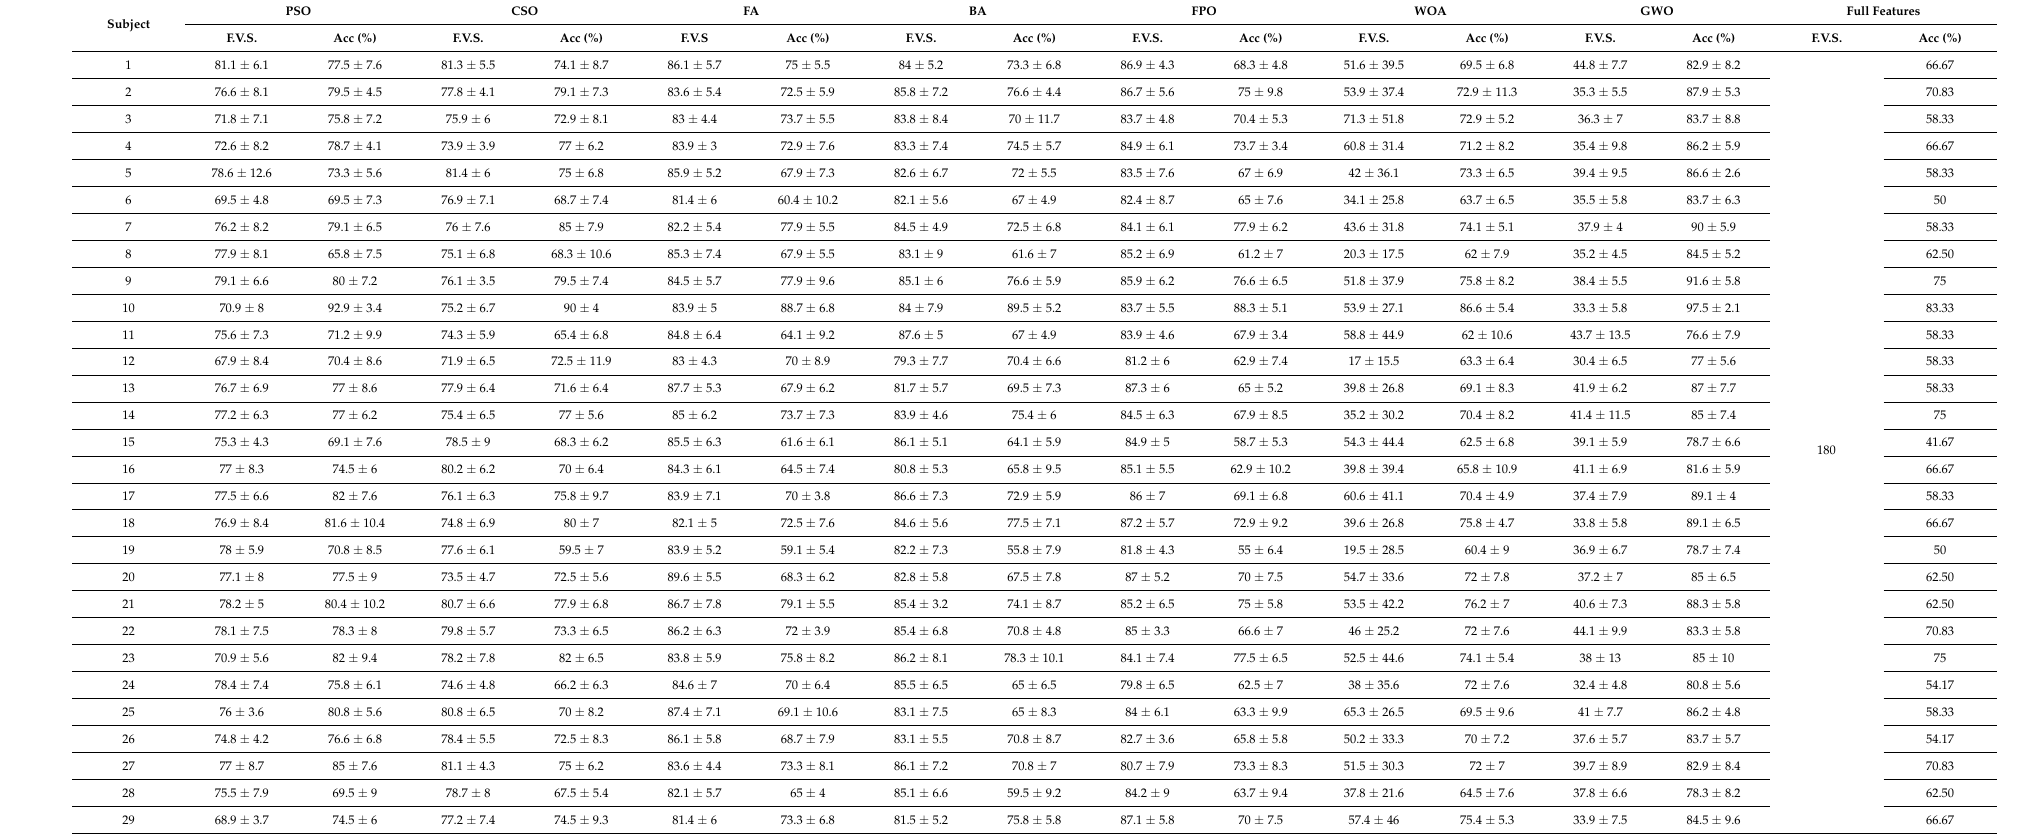
Table 4. Classification performance of each subject for the LHMI, RHMI, MA, and baseline tasks in terms of the accuracy (Acc) and the feature vector size (F.V.S.) (data represented as the mean ± the standard